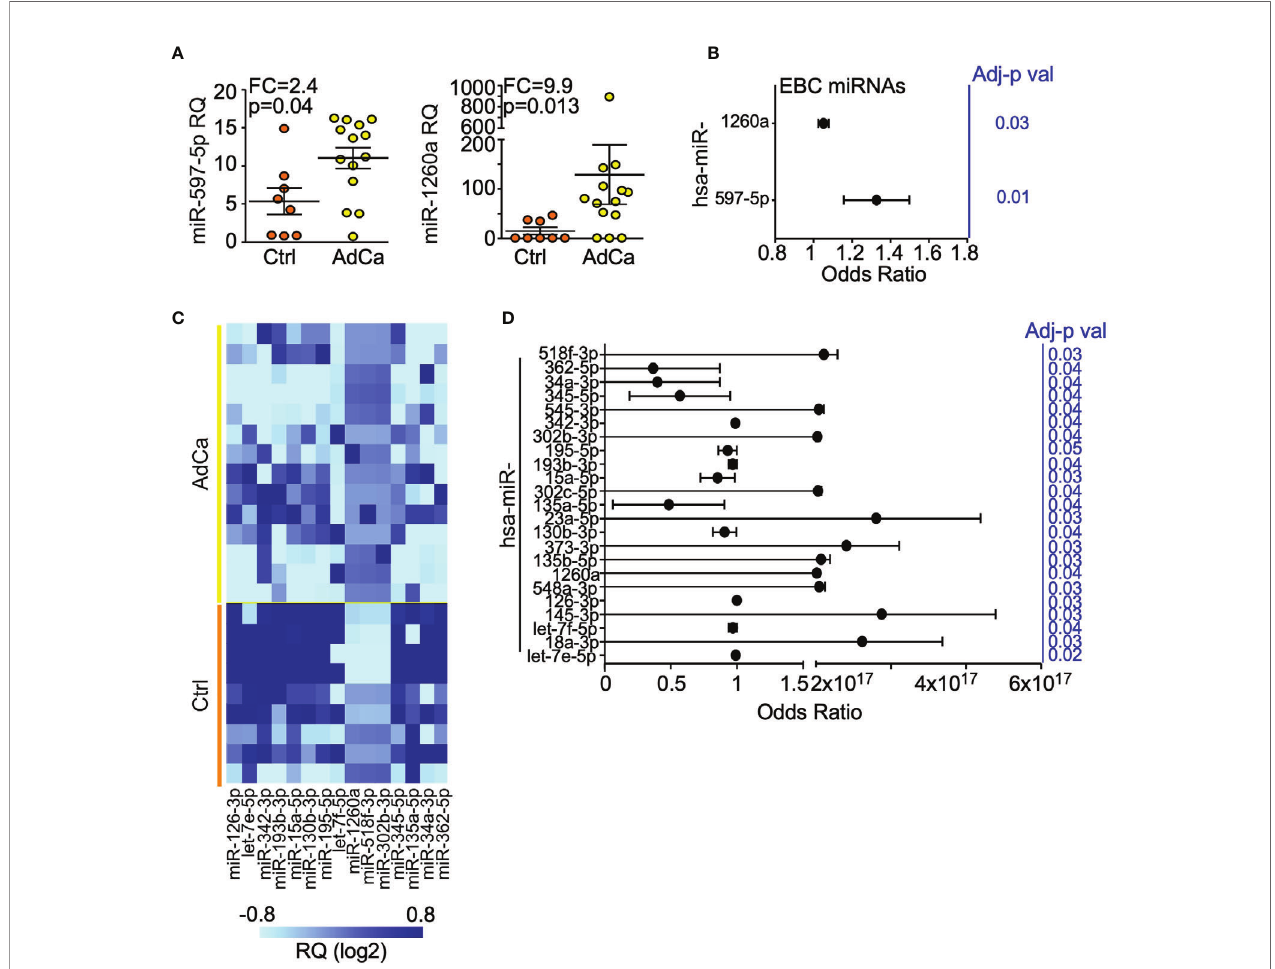
FIGURE 2 | miRNAs expression pro fi le in EBC and plasma from AdCa patients and healthy controls. (A) miR-597-5p and miR-1260a expression levels in the EBC of patients with AdCa or healthy controls (Ctrl). Each dot is a case; lines, mean with interquartile range; FDR-adjusted p val <0.25; FC, fold-change; RQ, relative quantity. (B) Diagnostic value of EBC-miRNAs in identifying subjects with lung AdCa. Forest plot showing the odds ratio for the EBC miRNA miR-597-5p and miR- 1260a. Bars, 95% con fi dence interval. Odds Ratio was adjusted for age, smoke and BMI; p values are from logistic regression analysis. (C) Heatmap of the plasma miRNAs differentially expressed (FC >2; FDR-adjusted p val <0.25) between AdCa patients and control (Ctrl) subjects. The heatmap was generated with GraphPad Prism software. (D) Diagnostic value of plasma-miRNAs in identifying subjects with lung AdCa. Forest plot showing the odds ratio for the indicated plasma miRNAs. Bars, 95% con fi dence interval. Odds Ratio was adjusted for age, smoke and BMI; p values are from logistic regression analysis; FC, fold change.